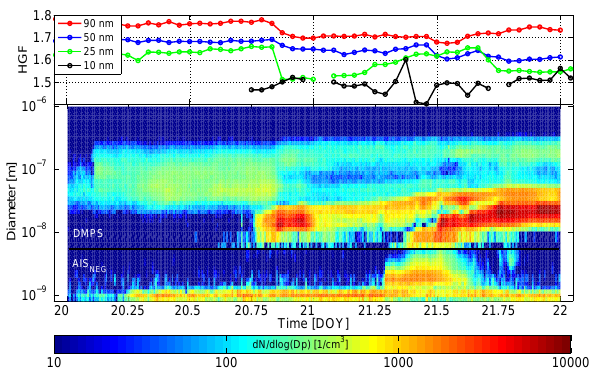
Fig. 9. Negative (upper panels) and positive (lower panels) air ion number size distributions on 21 and 27 January,